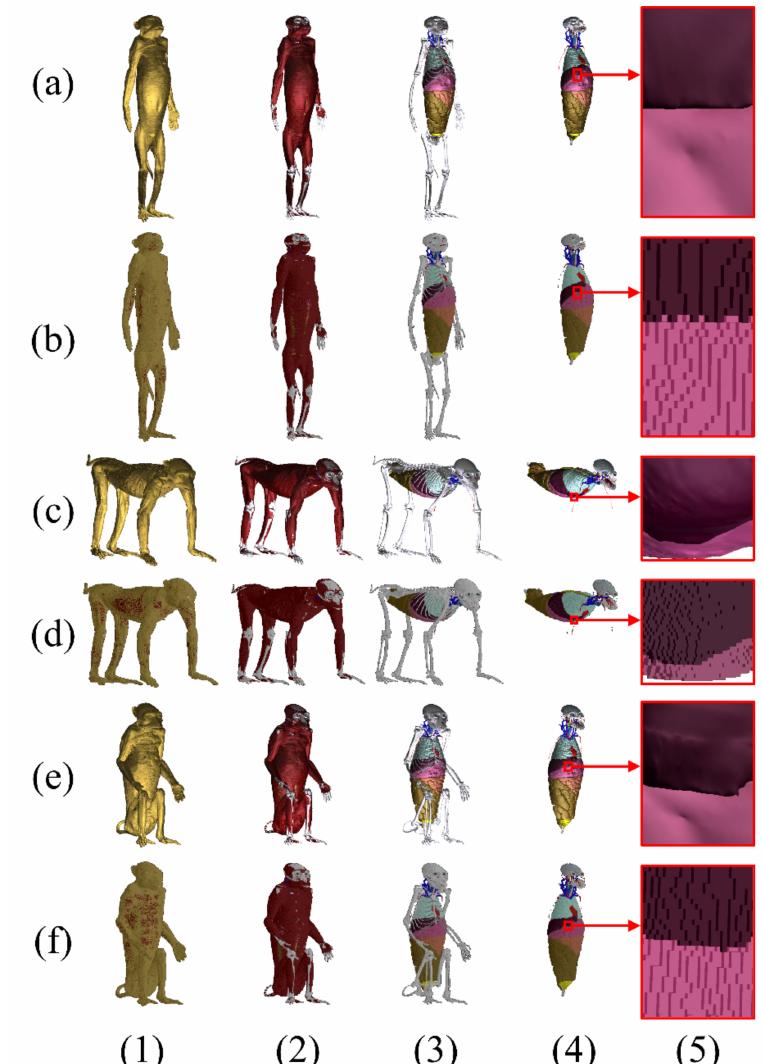
Figure 3. Surface models and voxel phantoms of a monkey in an ( a and b rows) an anatomical position, ( c and d rows) a quadrupedal position, and ( e and f rows) a sitting position with 177 struc- tures. (Column 1 ) The surface models and voxel phantoms of the whole body, (column 2 ) the skin, (column 3 ) muscle, and (column 4 ) peeled bones. Differences between ( a - 5 , c - 5 , e - 5 ) the meshes of the surface models and ( b - 5 , d - 5 , f - 5 ) the voxels of the phantoms can be seen in the magnified views. Table 1. Properties of surface models and phantoms of a rhesus monkey in anatomical, quadrupedal, and sitting positions. Total Number of Files of Three File Size of File Size of File Size of File Format of Positions Anatomical Quadrupedal Sitting Three Positions (Number of Files Position Position Position Per Position) Surface models STL 531 (177) 324 Mbytes 325 Mbytes 326 Mbytes Phantoms TXT *